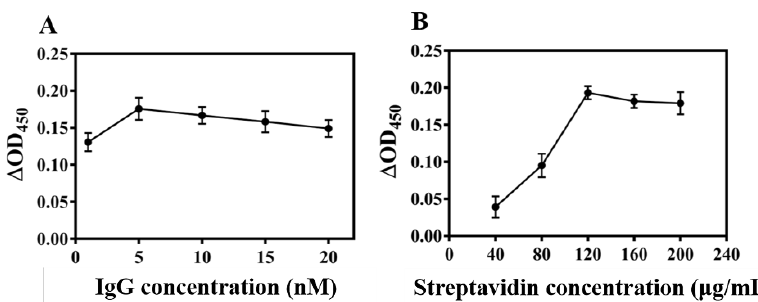
Figure 3. The common colorimetric detection method parameters’ optimization. ( A ) Optimization of IgG-biotin concentration. ( B ) Optimization of SA-HRP concentration. The concentration of S. aureus used was 3.3 × 10 7 CFU/mL. The error bars represent the standard deviation of three measurements.